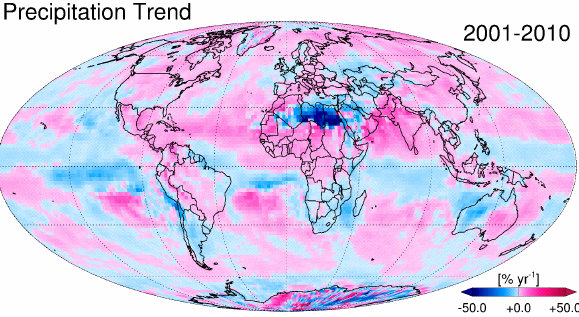
Figure 6. Linear trend in %year − 1 for surface precipitation in both simulations BASE and